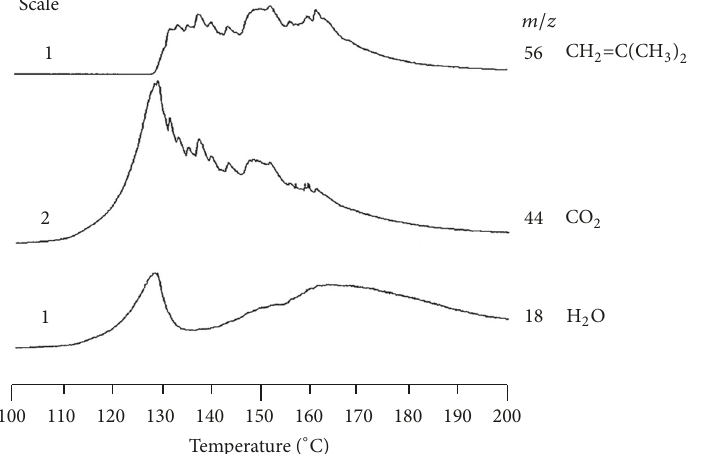
Figure 4: Thermal release patterns of ions for compounds from Boc-Gly-L-Asp ( 5a ) by DTA/TG-MS analysis. Ion source: EI, 70 eV; temperature: 250 ∘ C. Detection: EI range, 𝑚/𝑧 = 17 to 100; interval, 1.5s; gain, 2.5; pipe heater: 280 ∘ C. GC oven: 150 ∘ C; injection: 200 ∘ C.